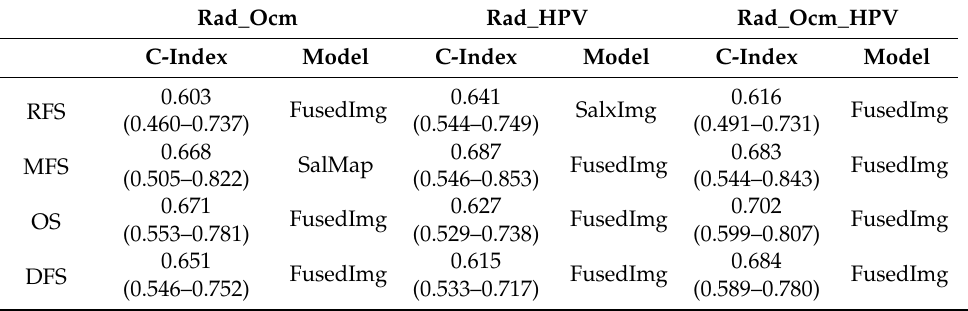
Table 3. The highest C-index (95% confidence interval) of Rad_Ocm, Rad_HPV, and Rad_Ocm_HPV for outcome prediction in 123 OPC patients from testing cohort; models were selected from Supplementary Table S2.